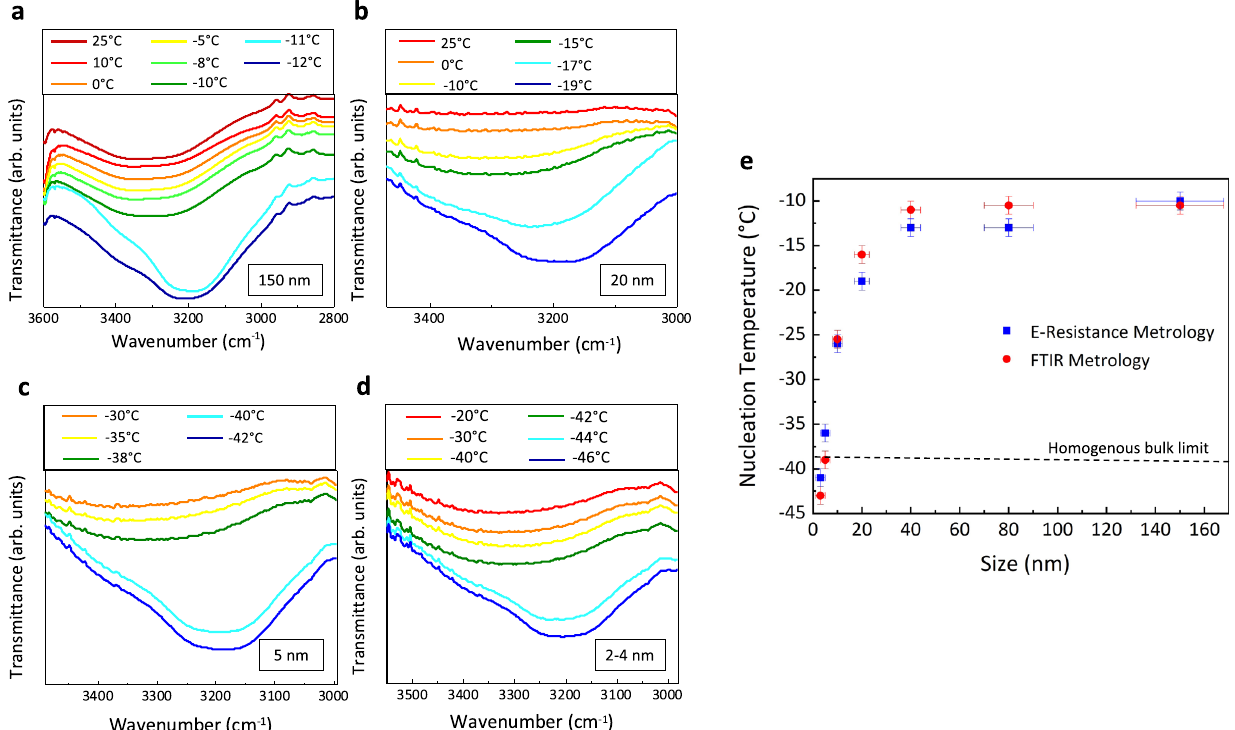
Fig. 3 FTIR metrology. FTIR spectrum of nanodroplets in various pore dimensions. a For 150 nm nanodroplets, at the temperature of − 11 °C, the OH stretch peak is narrowed and red-shifted to a wavenumber of ~3200 cm − 1 . This redshift indicates the water – ice phase change and provides T N value at this length- scale. b The redshift occurs at a temperature of − 17 °C for 20 nm water droplets. c For 5 nm water droplets, the narrowing of OH stretch peak occurs at a temperature of − 40 °C, while the redshift goes to lower wavenumbers compared to those of larger nanodroplets (150, 80, 40, 20, and 10 nm). This suggests a shorter O – H bond due to the con fi nement effect for the ice formed. d The T N value for 2 nm droplets becomes ~ − 44 °C. A similar con fi nement effect on the shortening of O – H bonds is observed for these droplets. That is for nanodroplets smaller than 5 nm, the formed ice phase has a different bond length compared to the bulk ice. e The nucleation temperature of nanodroplets measured through two independent metrologies is shown as a function of length-scale. For nanodroplets of 2 nm, the nucleation temperature drops below the limit of homogeneous bulk nucleation. In e , the horizontal error bars denote variations in the dimension of the water droplets, and the vertical errors bar denotes experimental errors in the measurement of nucleation